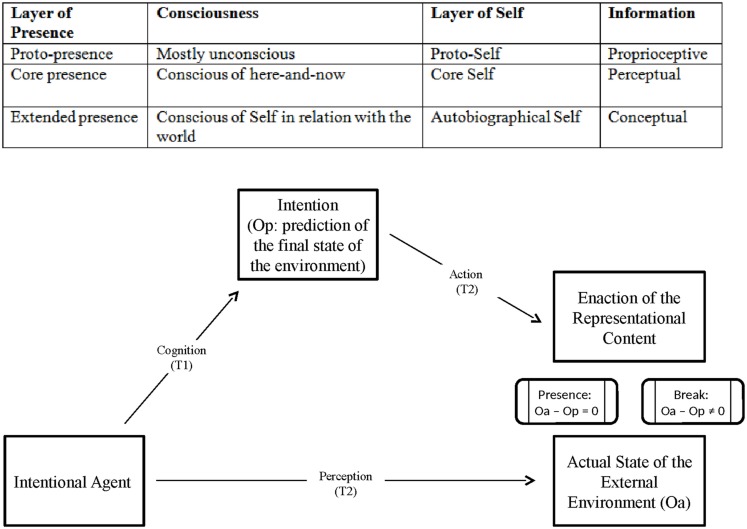
Layers of presence and layers of Self, and a representation of the feeling of presence emerging from intention enacting and action monitoring (adapted from Waterworth and Riva, 2014).